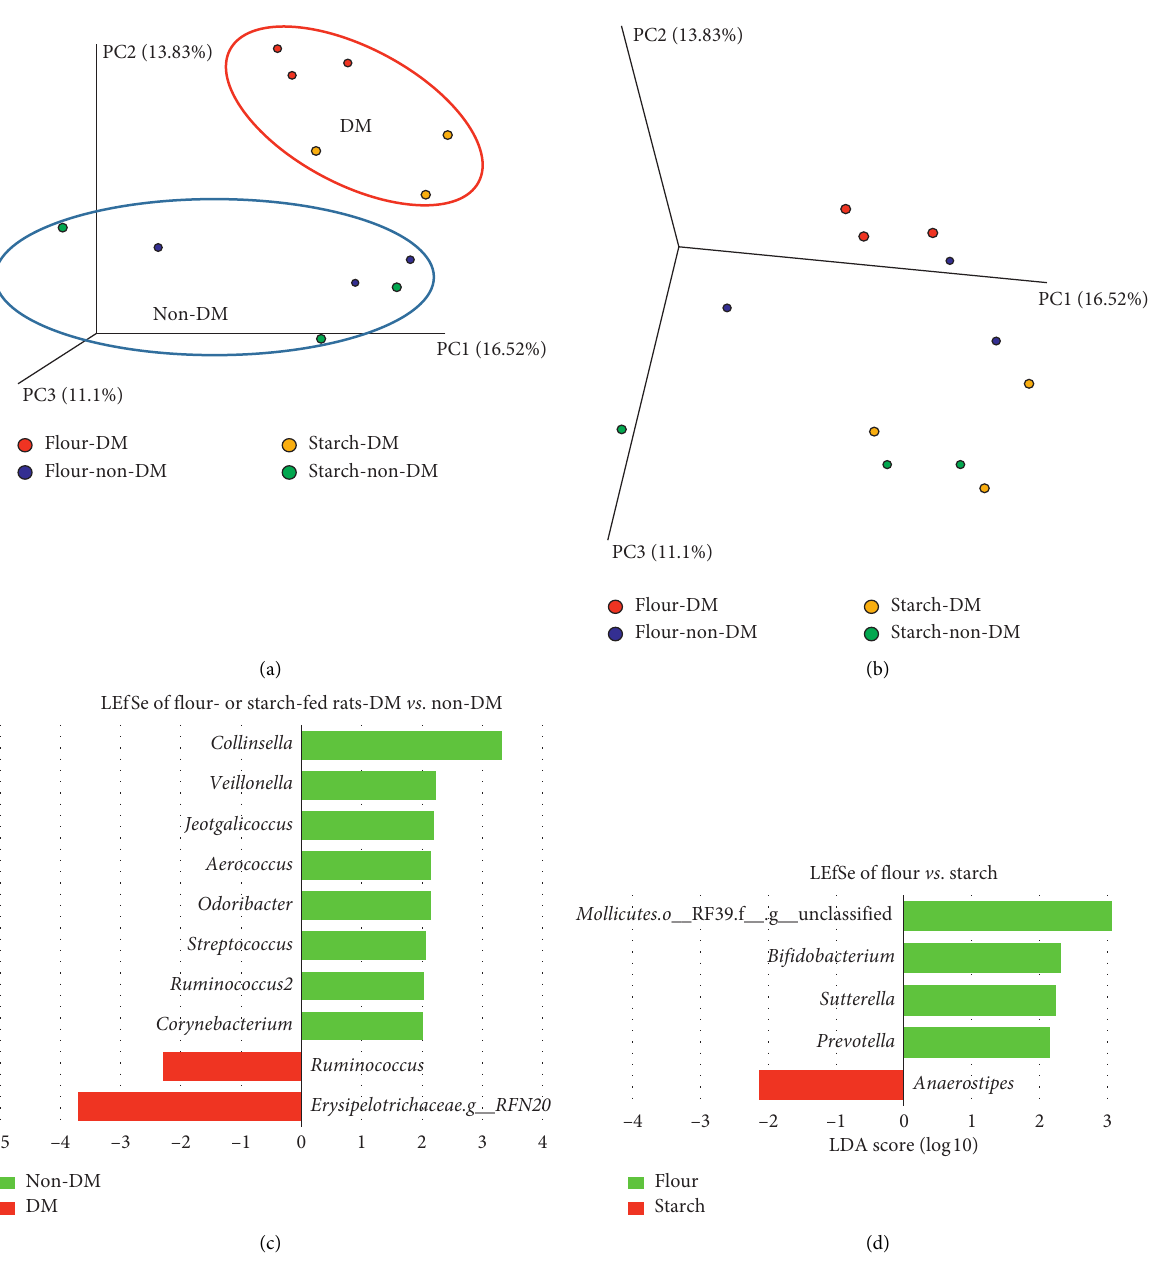
Figure 4: (a, b) β -diversity analysis (unweighted UniFrac) of week 4 microbiota of DM and control (non-DM) rats on the two taro-based diets. (a) Representation to show separation between DM and non-DM; (b) same graph as in (a), but rotated to show separation between taro starch and taro flour. (c, d) Linear discriminant analysis effect size (LEfSe) of DM status (c) and taro starch- vs. taro flour-fed rats at week 4 (d) in taro-fed rats (excl.